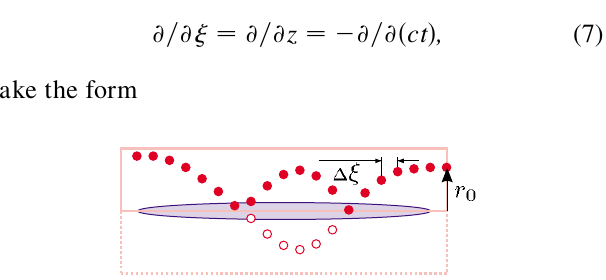
FIG. 2. (Color) Trajectory of a plasma macroparticle in the simulation